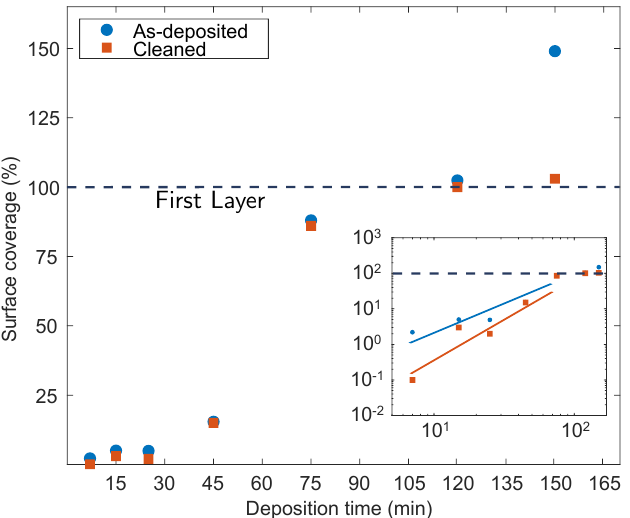
Figure 3. Molecule surface coverage vs. deposition time. Coverage values over 100% indicate the completion of the first molecular layer and the growth of a second layer on top of the first one. Inset: log-log chart of the same data. Blue and orange lines are a guide to the